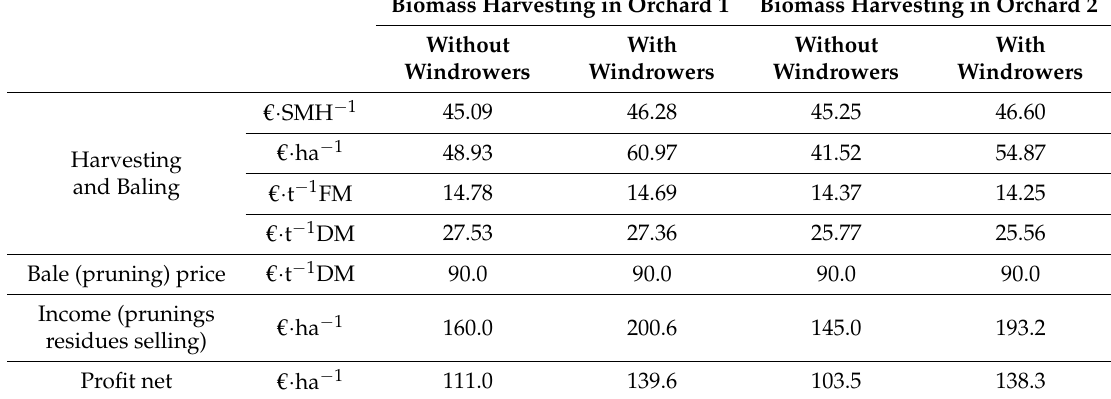
Table 6. Unit costs and potential profits for evaluated pruned biomass harvesting variants in the apple orchards.